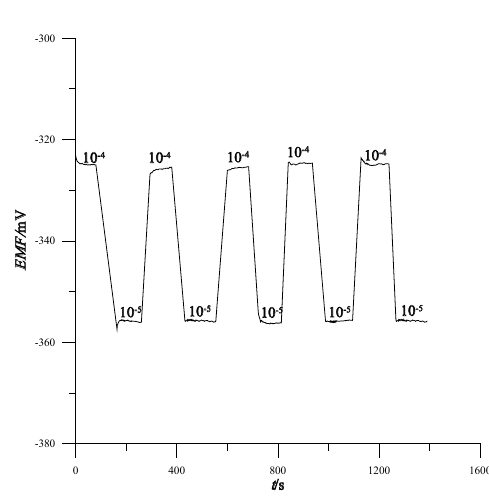
Figure 9. Changes of electrode potential with time determined in 0.1 M Zn(NO ) . Standard deviations given on the plot 3 2 are determined for the same three electrodes 6b and 8 respectively.